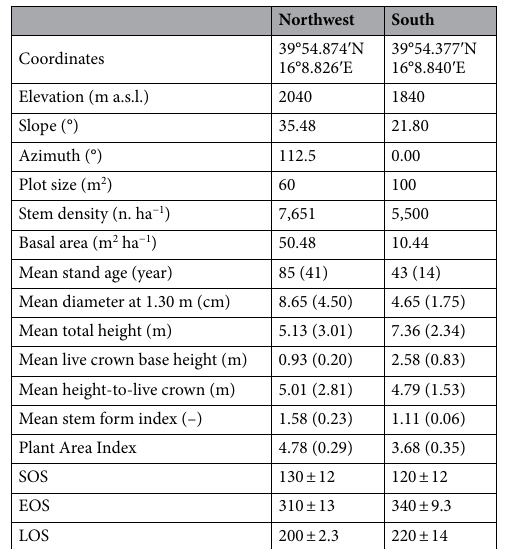
Table 1. Summary of F. sylvatica treeline stand structure attributes studied in the Serra del Prete (southern Apennines). In brackets values of 1st standard deviation are reported. Metrics of land surface phenology and greenness are derived from NDVI time series extracted from MOD13Q1 250 m spatial resolution and 16-day temporal resolution for the period 2016–2019. SOS, start of the growing season; EOS, end of the growing season; LOS, length of the growing season (see supplementary method for details of the numerical